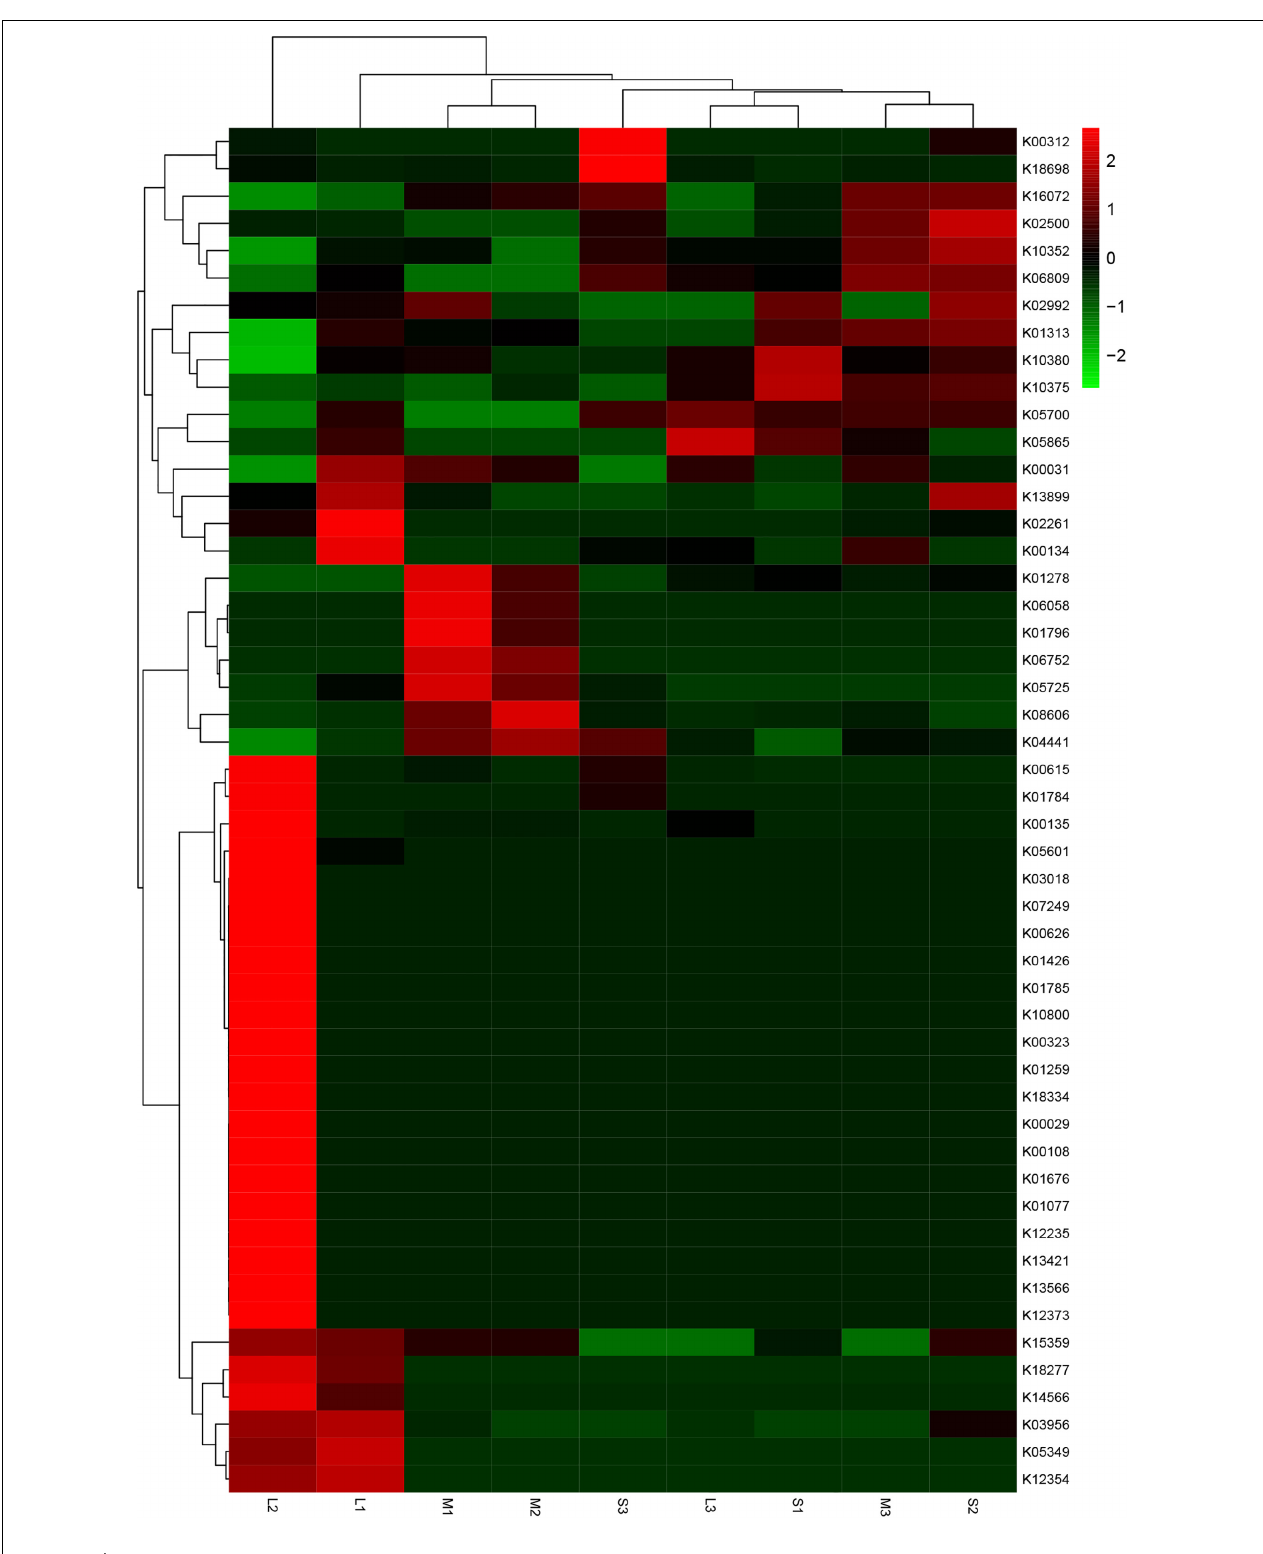
FIGURE 9 | Heat map of clustering analysis of the top 50 KO in terms of relative abundance among the three groups. Red represents the species and KO with higher abundance in the corresponding sample, and green represents the species and KO with lower abundance.